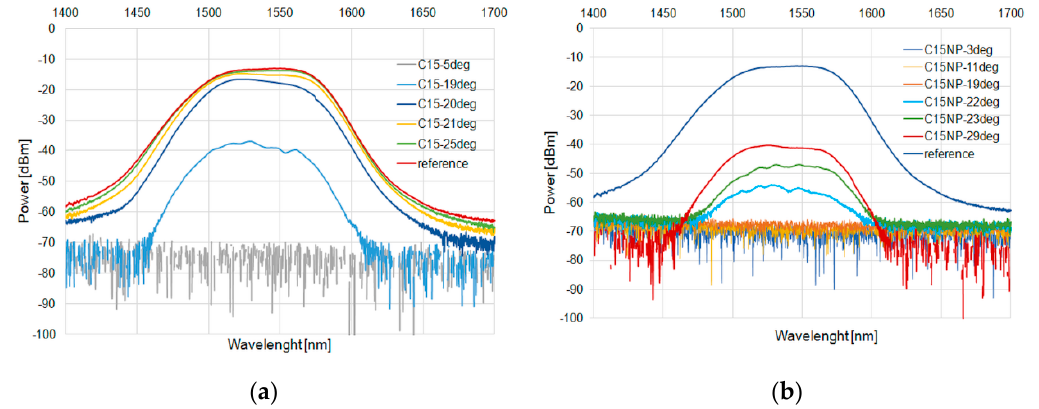
Figure 9. Heating process in C15 ( a ) and with an admixture of NPs ( b ) for SLED 1400–1700 nm.